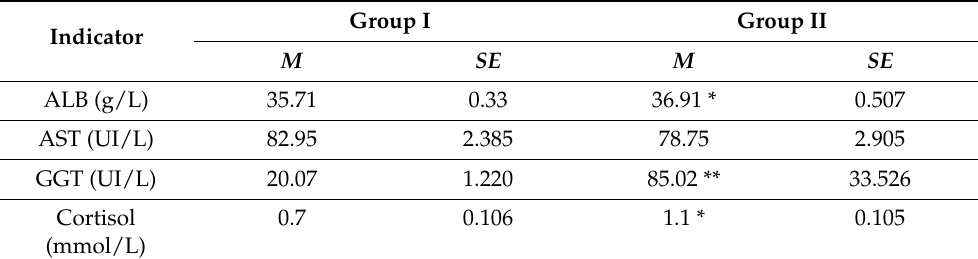
Table 1. Differences between blood parameters according to examining non-esterified fatty acid (NEFA) concentration.